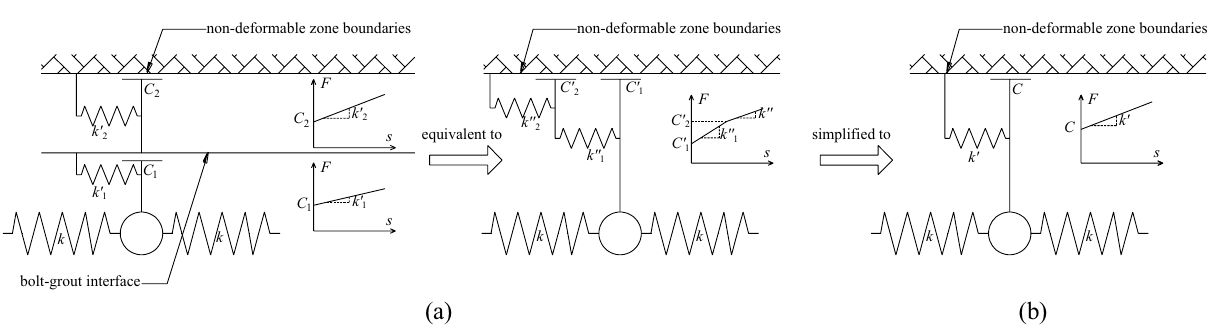
Figure 9. Evolution of the spring-slider model. ( a ) When the bolt–grout interface and the grout–rocksoil interface are both combinatorial coupling; ( b ) The spring-slider